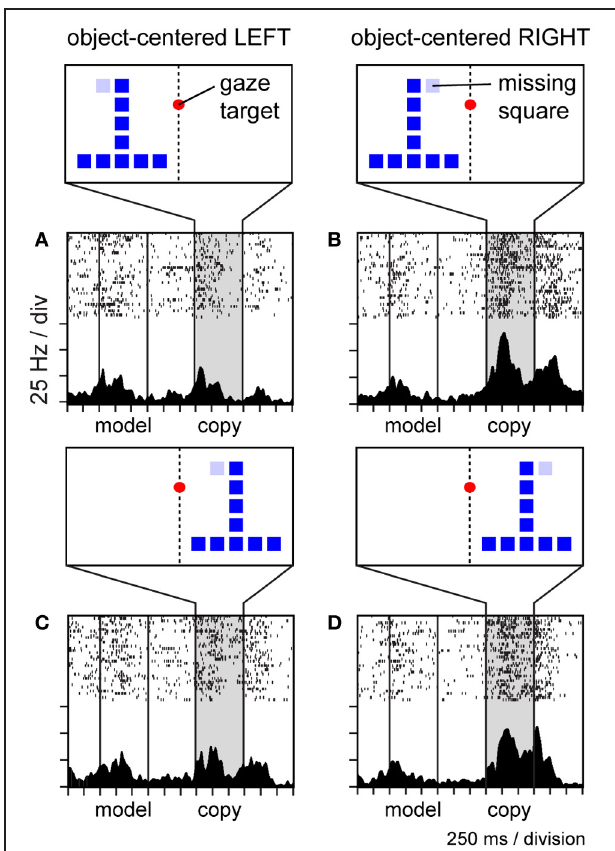
FIGURE 7 | Activity of a single area 7a neuron coding the location of the missing square in the copy object in object-centered spatial coordinates. The location of the missing square is indicated in light blue but was not visible to the monkey (the copy object consisted only of an inverted “T” configuration of dark blue squares in these trials). The copy object was presented to the left (A,B) or right (C,D) of the gaze fixation target at random over trials. The missing square was located on the relative left (A,C) or right (B,D) side of the object, relative to its intrinsic midline, at random over trials. Consequently, the object-centered and viewer-centered side (left or right) of the missing square in the copy object were statistically independent spatial variables. This neuron was activated whenever the missing square was located on the relative right side of the copy object (B,D) , regardless of whether the copy object appeared in left (B) or right (D) viewer-centered